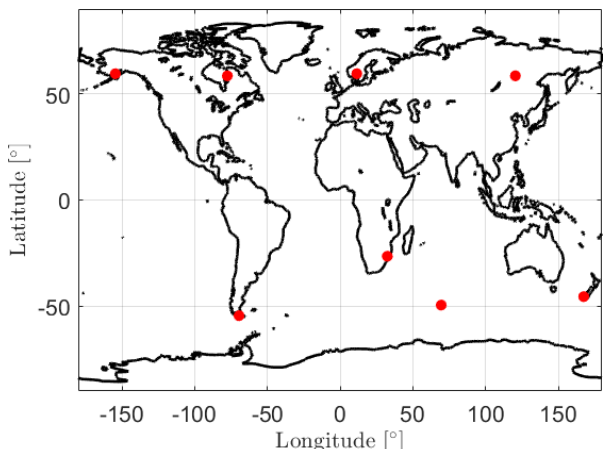
Figure 4. Example of the ground-based ground monitoring stations (GMSs) distributed in latitudes within ±60 ° , so that a maximum observation time gap not exceeding 1 h can be ganranteed for GRACE FO-1 on 14 August 2018. Note that the GMS located around 70 ° E and 50 ° S is above an island in the Indian Ocean.